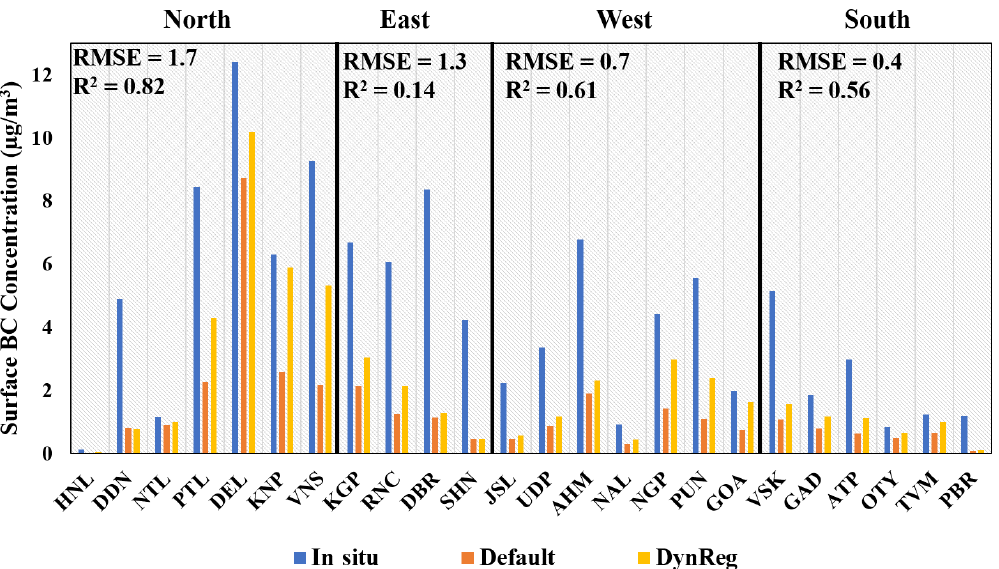
Figure 2. Comparison of simulated BC surface concentration (µgm − 3 ) using the default and augmented model with in situ measurements from 24 cities across India (see Fig. S4 for definitions of the abbreviations). The locations of the cities are shown in Fig. S4. The RMSE (in µgm − 3 ) and R 2 values between the customized model simulations and surface measurements are also